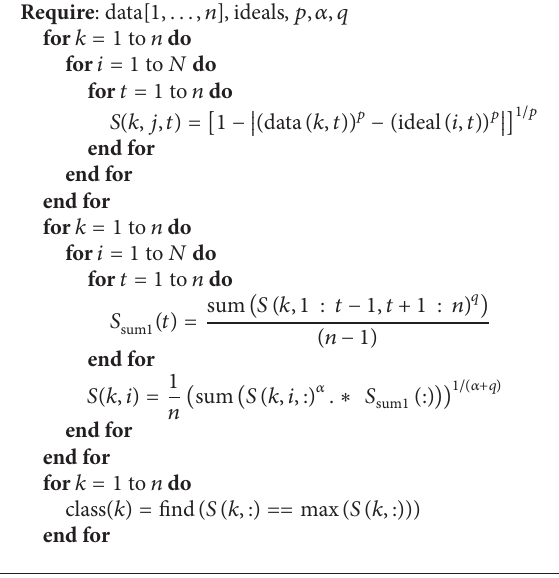
Algorithm 1: Pseudocode for the similarity classifier with the Bonferroni mean